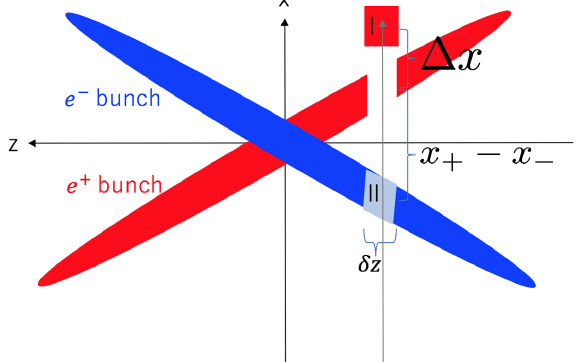
FIG. 1. Illustrative representation of the evaluation of the cross- wake